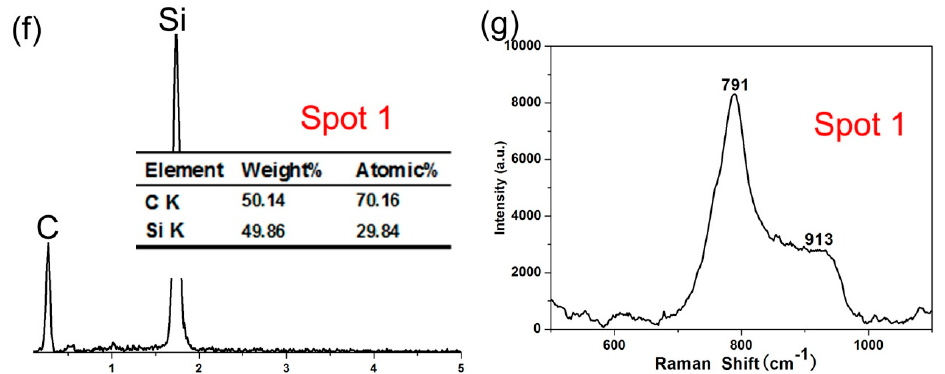
Figure 2. ( a ) Low ‐ magnification of the needling felt layer, ( b ) low ‐ magnification of the non ‐ woven layer, ( c ) high ‐ magnification, ( d ) columnar, and ( e ) beaded SEM images of the SiCNWs, ( f ) EDS of the SiCNWs, ( g ) and Raman spectra of the